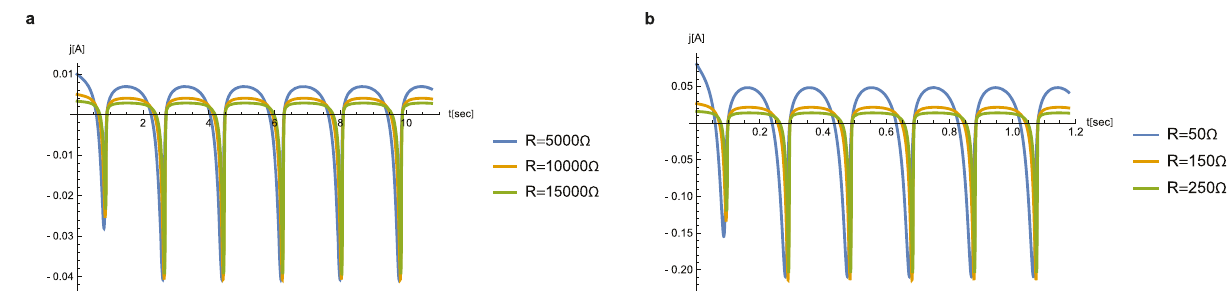
Fig. 6 Temporal pro fi le of the electric current. Curves are plotted for two different lubricating liquids, a PC and b IL, each presented for three different electric loads. Parameters: a N ¼ 10 2 ; ω ¼ 3 : 5s (cid:5) 1 , V ref ¼ 50V; b N ¼ 10 3 ; ω ¼ 32 s (cid:5) 1 ; V ref ¼ 4V.